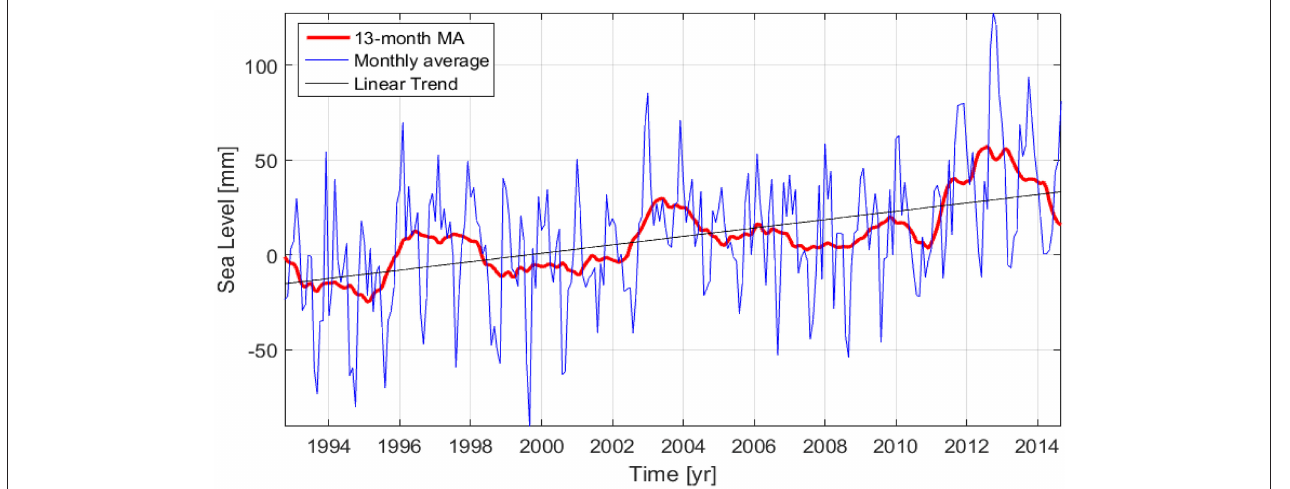
FIGURE 6 | Regional sea level variations over 1993–2015. Monthly averaged values are shown in blue and 13-month averaged values are shown in